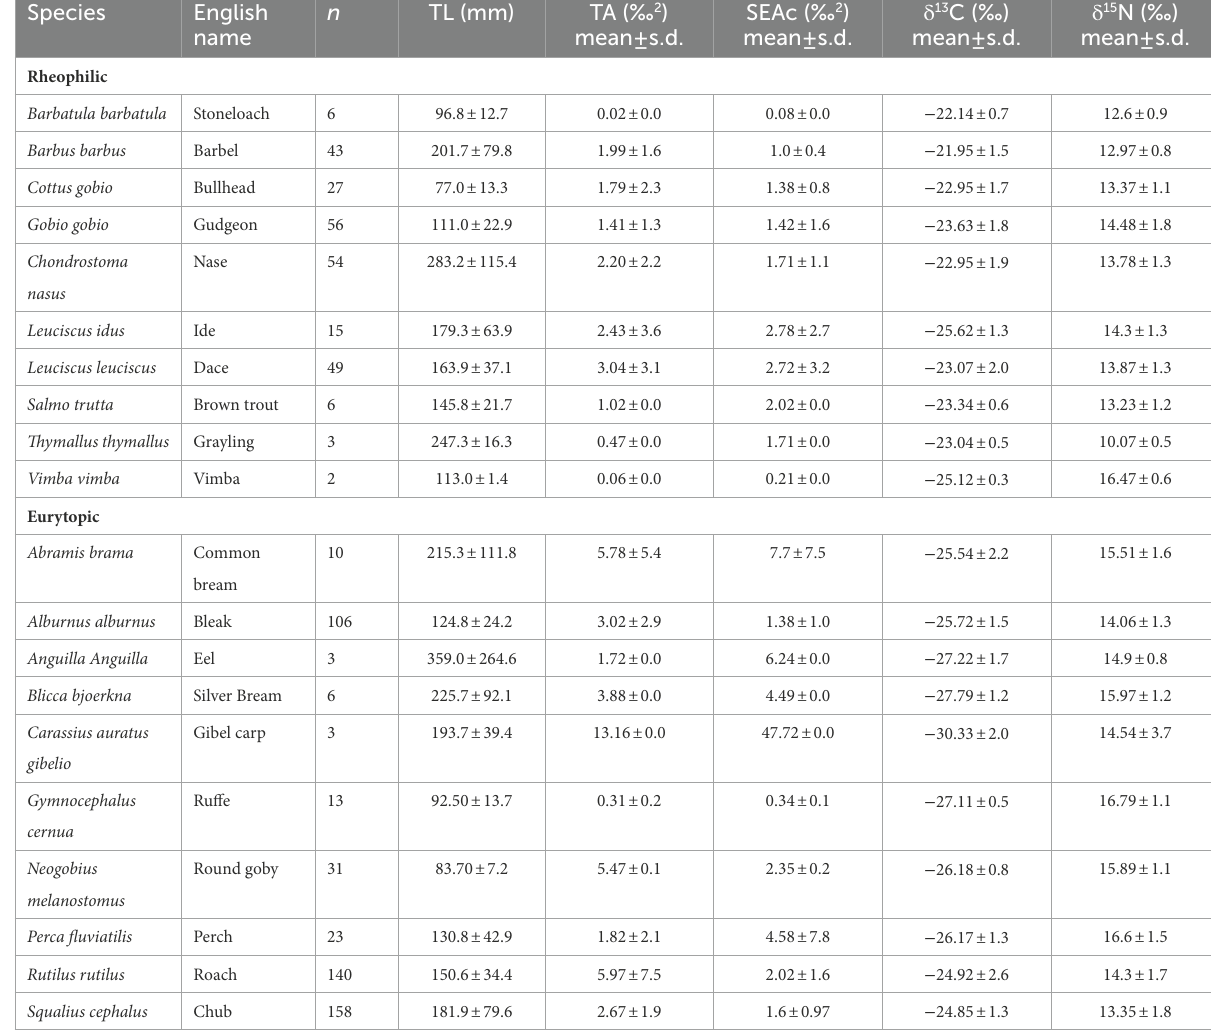
TABLE 1 Number of samples and size of individuals (Total Length: TL) used for each fish species, together with species level Bayesian trophic niche metrics measured, including the total area of convex hull (TA), Standard Ellipse Area (SEA), ellipse area corrected for small sample size (SEAc), species-specific variance in δ 13 C and δ 15